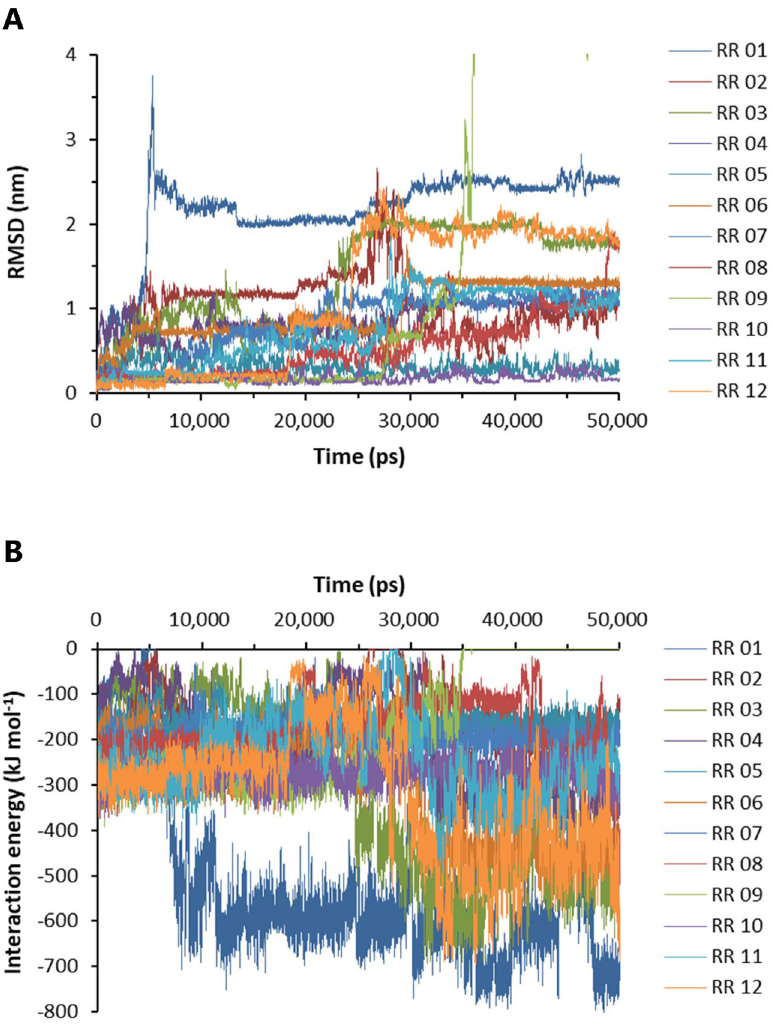
Figure 6. Binding stability and interaction energy of arginine dipeptide at different binding sites of A β 42 . ( A ) The root-mean-square deviation (RMSD) of the heavy elements of arginine dipeptide (RR) at different binding sites over time. ( B ) The interaction energy between A β 42 pentamer and arginine dipeptide. The labels of RR 01-12 correspond to A to L in Supplementary Figure S3, respectively. The interaction energy is the algebraic sum of Lennard-Jones and Coulombic potential energy.